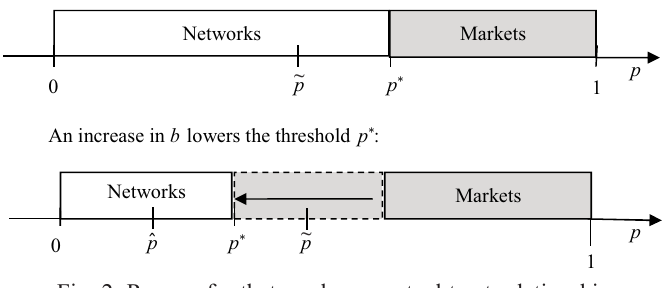
Fig. 2. Range of p that produces mutual trust